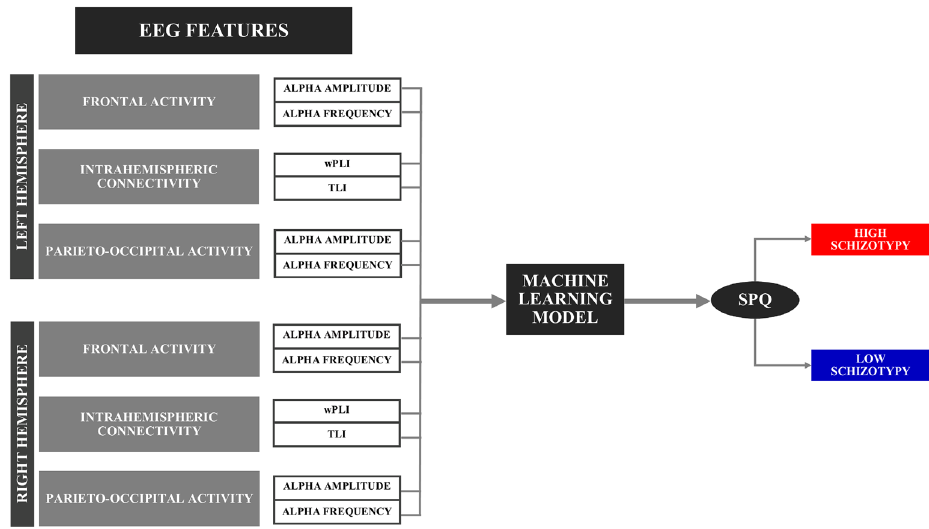
Figure 3. EEG features included in the machine learning pattern